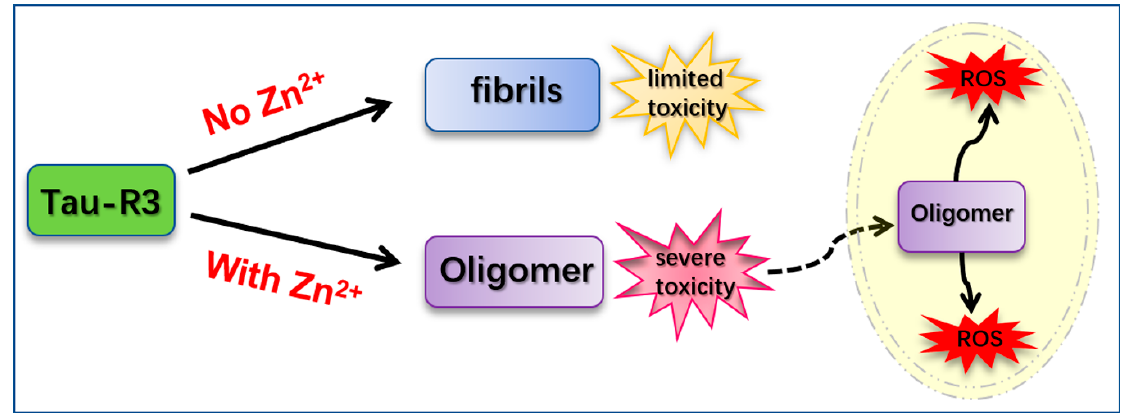
Figure 9. Hypothetical model. The solid arrows represent the process of generation, and the virtual arrow represents the process of entering the cell.